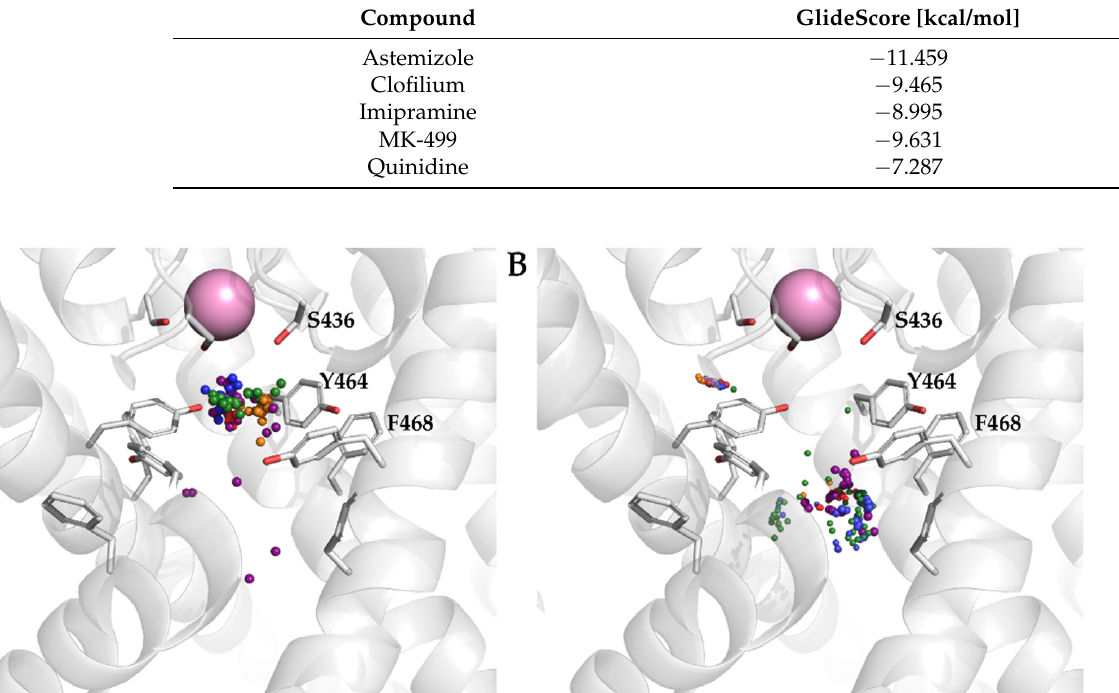
Figure 4. Distribution within the homology model of the K V 10.1 open pore conformation of amines ( A ) and aromatic moieties ( B ) in the top 20 ranked poses per ligand. The small spheres in different colors represent nitrogen amine atoms ( A ) and geometric centers of aromatic rings ( B ) of the docked ligands. Spheres that represent astemizole, clofilium, imipramine, MK-499, and quinidine are blue, orange, green, red, and purple, respectively.